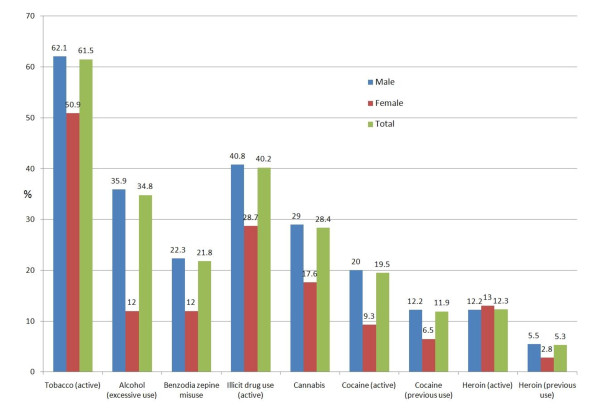
Health problems coded as substance abuse (71.2%; 95%CI 69.3-73.1)